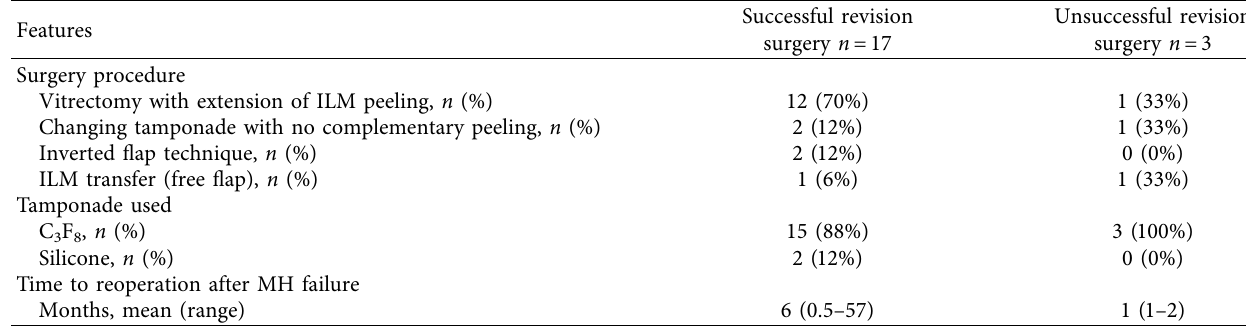
Table 2: Details of the revision surgery